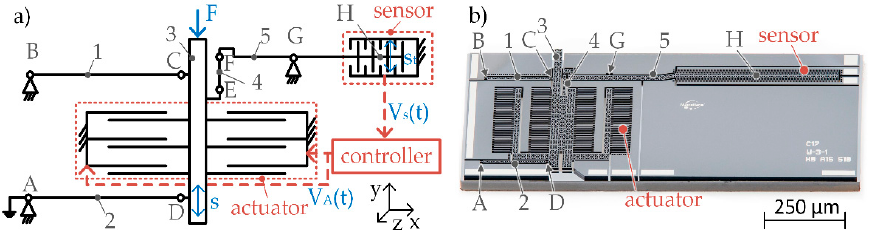
Figure 1. ( a ) Schematic illustration of the working principle of the MEMS-based weighing balance including the mechanical parts (black), the electrical parts and the electrical periphery (red). (1) upper lever, (2) lower lever, (3) shuttle, (4) coupling element, (5) transmission lever, V s voltage of the sensor signal, V A Voltage to actuate the shuttle in balance; ( b ) Photo-stacked overview image of the microfabricated MEMS-based weighing cell.